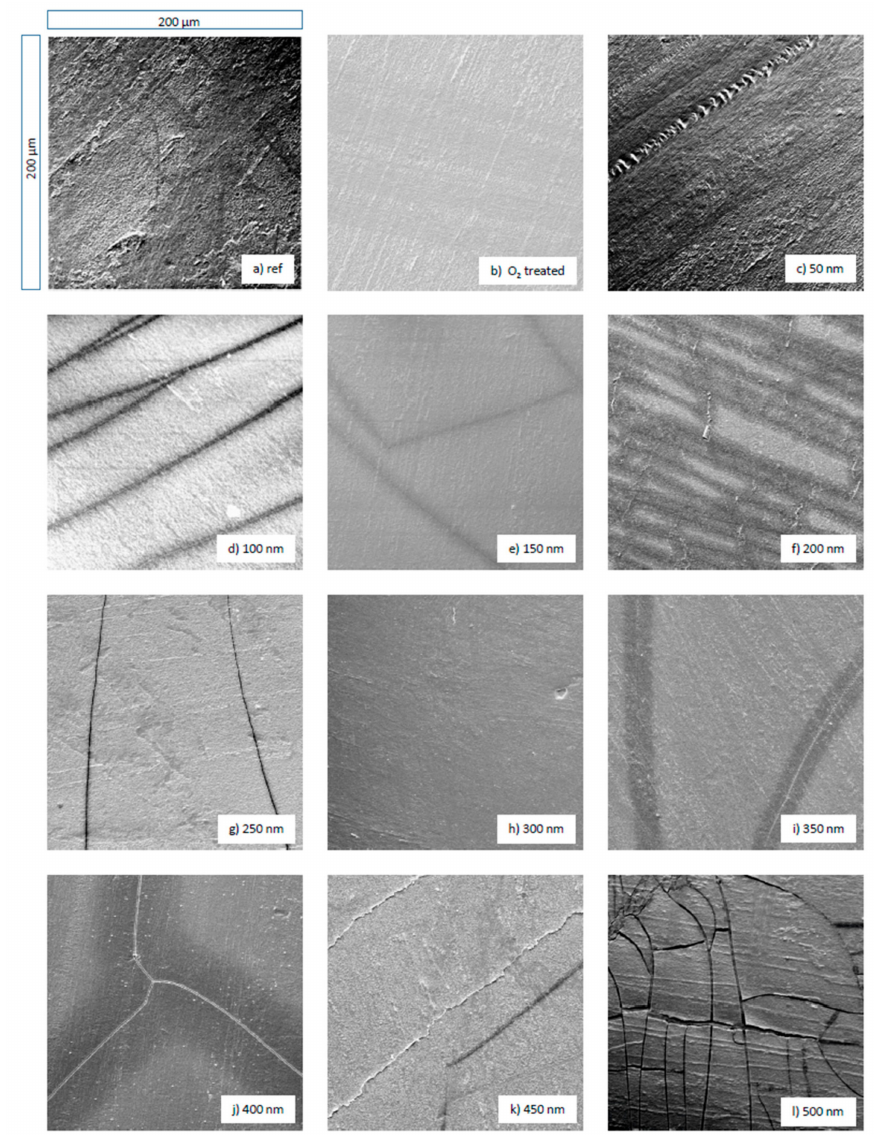
Figure 1. Scanning electron microscope (SEM) images of polybutylene adipate terephthalate (PBAT): ( a ) untreated reference sample, ( b ) treated with O 2 plasma and ( c )–( l ) coated with a-C:H layers. The series from ( c )–( l ) shows the changes in topography of an increasing a-C:H coating in 50 nm steps up to 500